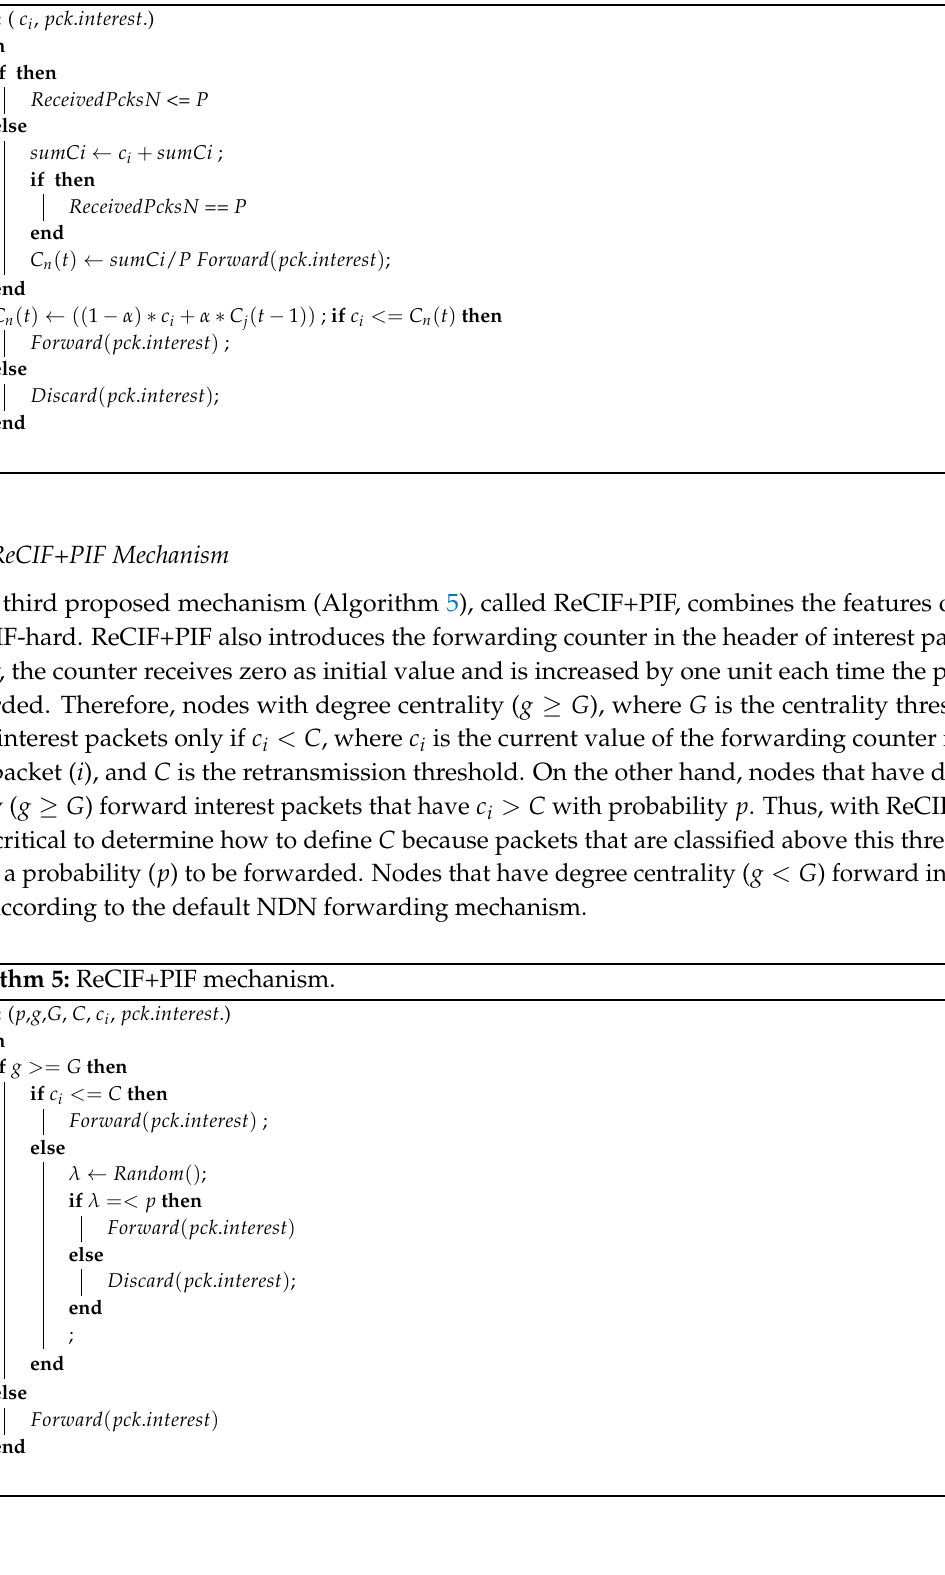
Algorithm 4: ReCIF-soft G=0 Mechanism.